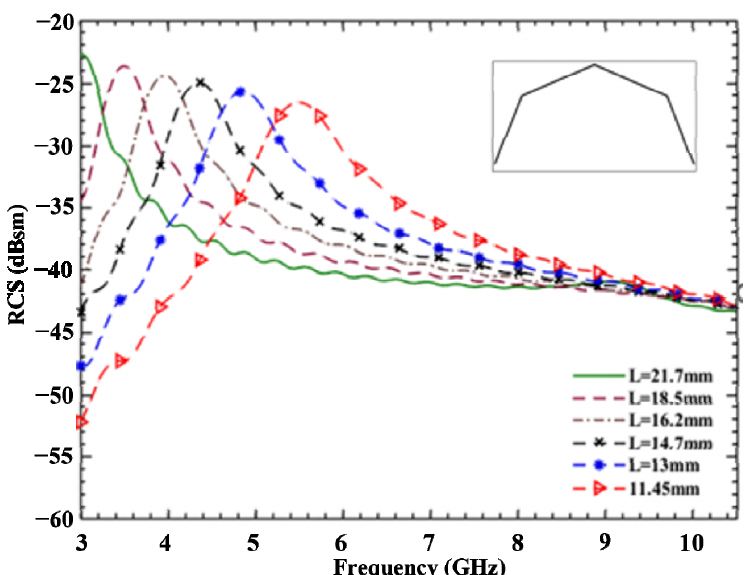
Figure 4. Effect of L N for a single bit resonator.